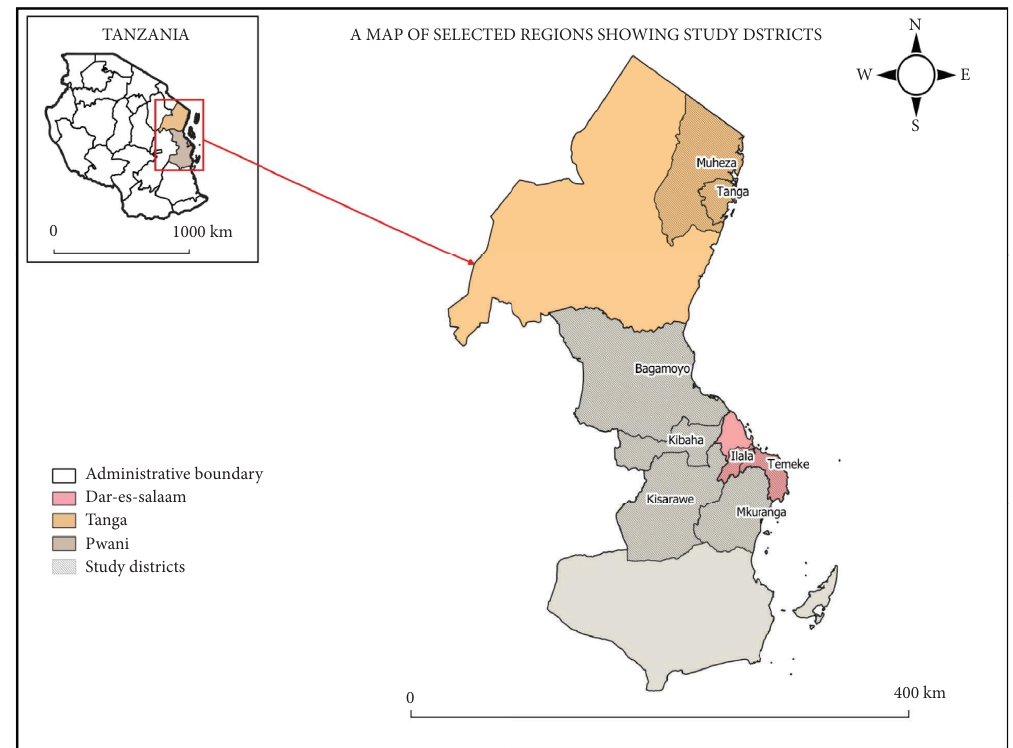
Figure 1: Map of the study area showing the districts selected for the study of the seroprevalence and risk factors of brucellosis in commercial cattle farms from selected districts of the eastern coast zone, Tanzania.